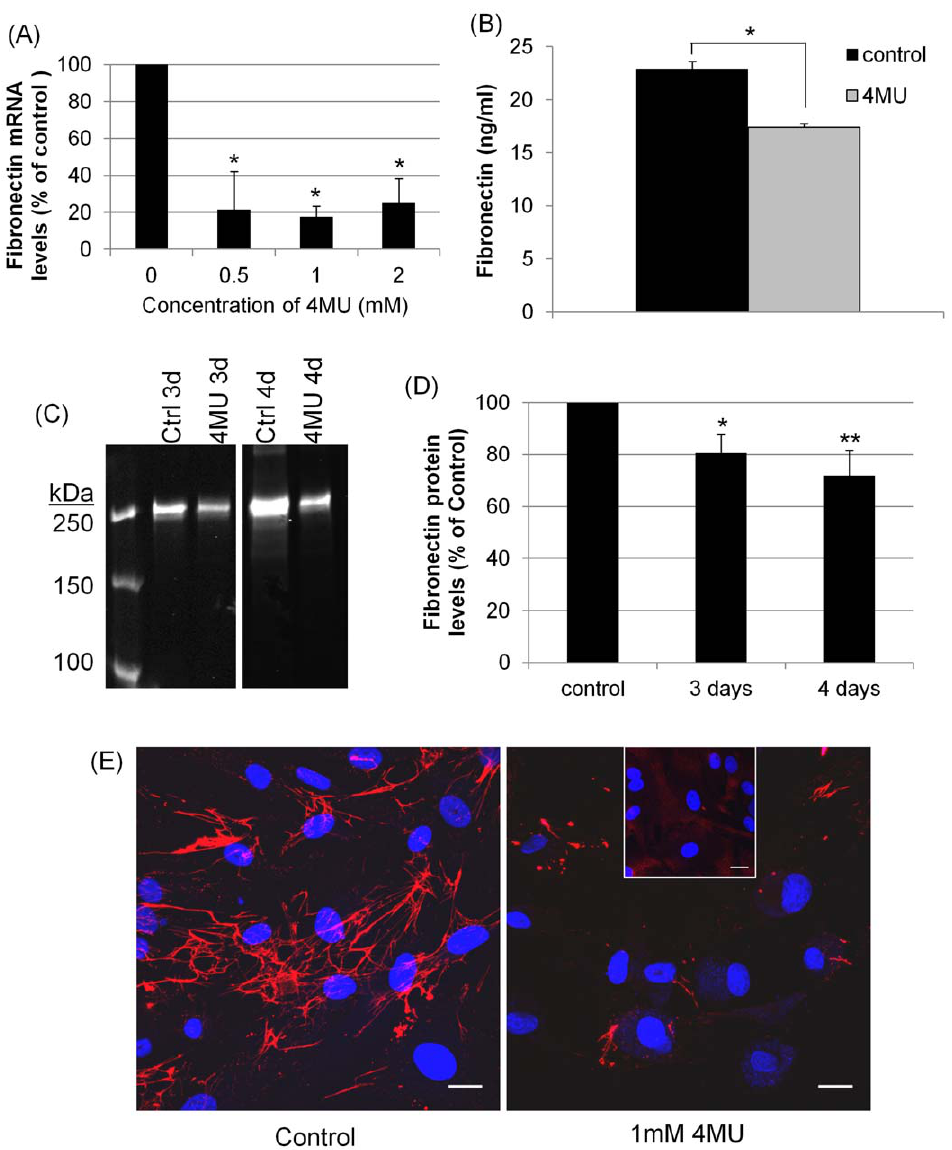
Figure 2. Fi bronectin levels in response to 4MU treatment. (A) Fibronectin mRNA levels by qRT-PCR in TM cells treated with 0, 0.5, 1 and 2 mM 4MU for 36 hours. mRNA levels were normalized to 18S RNA levels and presented as a percentage of the control. Error bars are the s.e.m.; n=3; * P , 0.01 by one-way ANOVA. (B) Fibronectin ELISA assay to measure total fibronectin (RIPA lysates and media) protein levels in TM cells. Cells were treated for 4 days with 1 mM 4MU or vehicle-control. Error bars are the s.e.m.; n=3. * P=0.0001 by an unpaired Student’s t-test. (C) Western immunoblots of fibronectin protein in conditioned media from TM cells treated with vehicle-control (ctrl) or 1 mM 4MU for 3 and 4 days. The MW markers and 3 day samples are from adjacent lanes of one immunoblot and the 4 days lanes are from adjacent lanes of a different immunoblot. (D) Densitometry of fibronectin showed a significant reduction with 4MU treatment. Fibronectin levels were normalized to total protein loaded and are presented as a percentage of the control. Error bars are the s.e.m.; n=6 for 3 days, n=5 for 4 days. * p=0.039 and ** p=0.02 by one-way ANOVA. (E) Fibronectin immunostaining of TM cells treated with vehicle-control or 1 mM 4MU for 4 days and viewed by confocal microscopy. Nuclei are stained with DAPI (control) or Draq5 (4MU). Scale bars=20 m m.